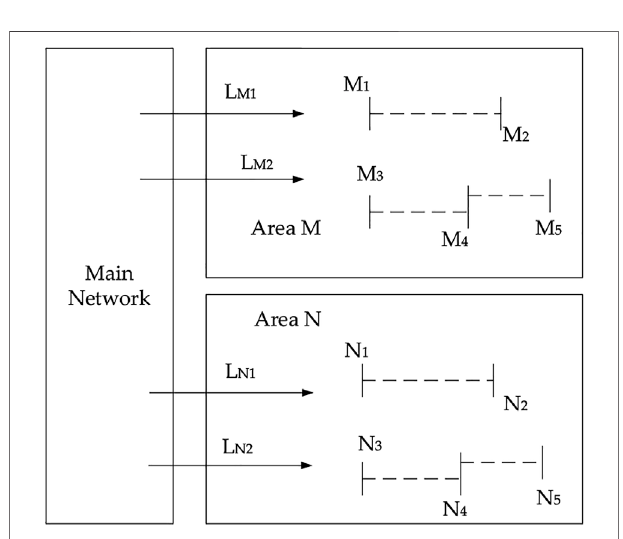
FIGURE 3 | Distribution network system diagram of an urban area.